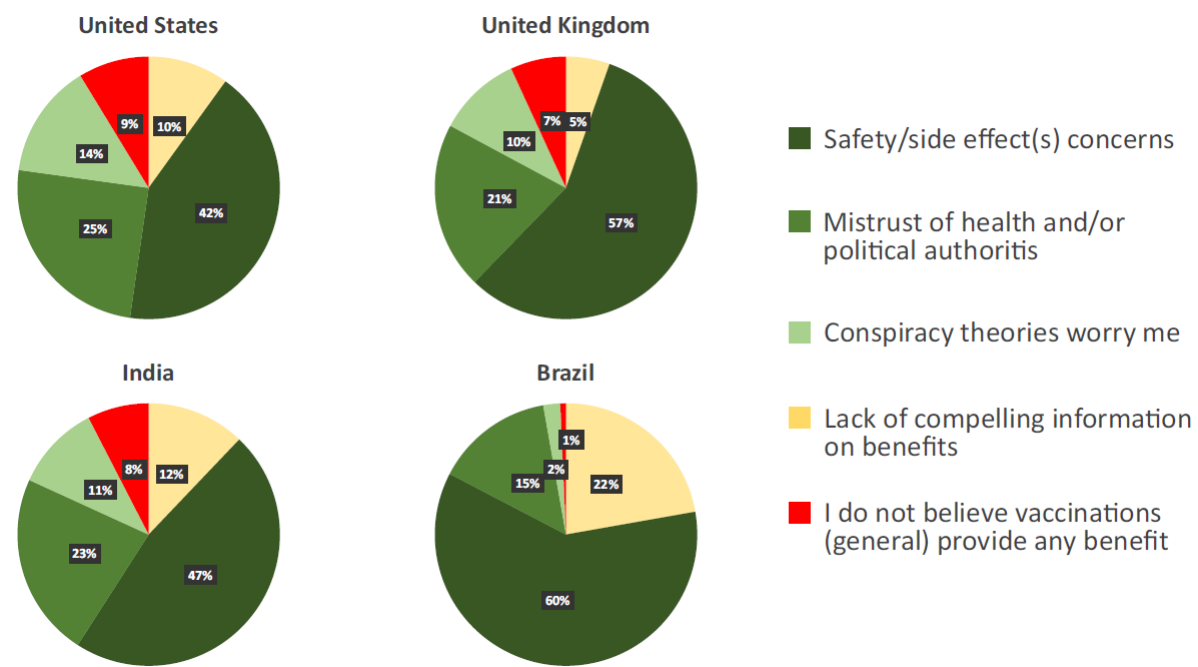
Figure 2. Reasons for hesitancy to receive a COVID-19 vaccine among respondents who selected Neutral/Not Open.